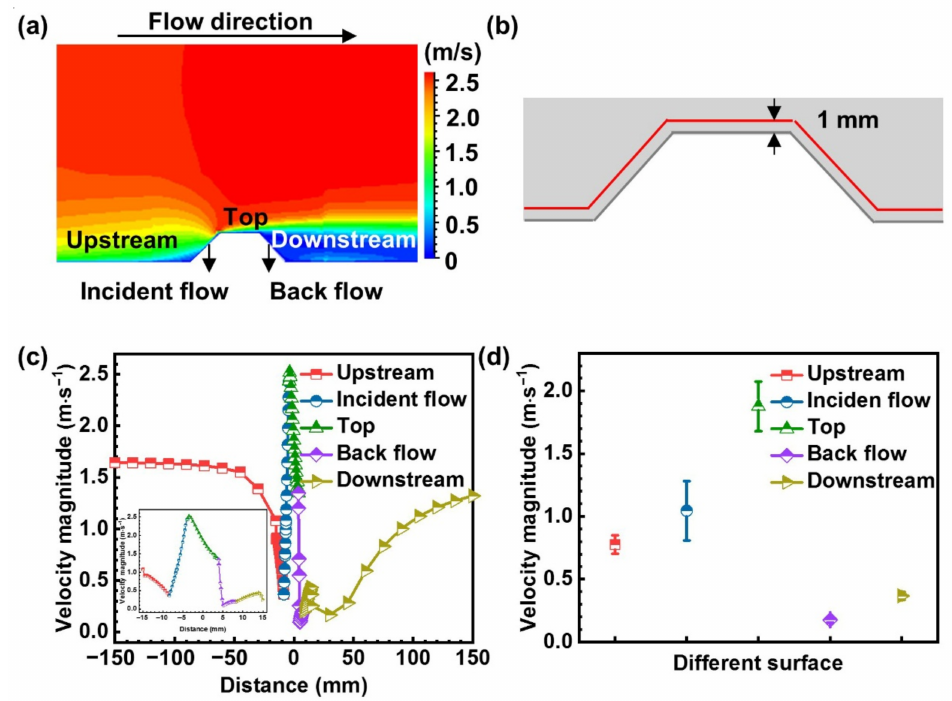
Figure 13. ( a ) Flow velocity contour around the WRH, ( b ) the location of the red line for monitoring the flow velocity distribution near the material surface, and ( c ) flow velocity variation at the red line in ( b ) near the WRH wall along the flow direction and ( d ) average flow velocity of samples in different surfaces of the WRH at the condition of the main flow velocity of 2.3